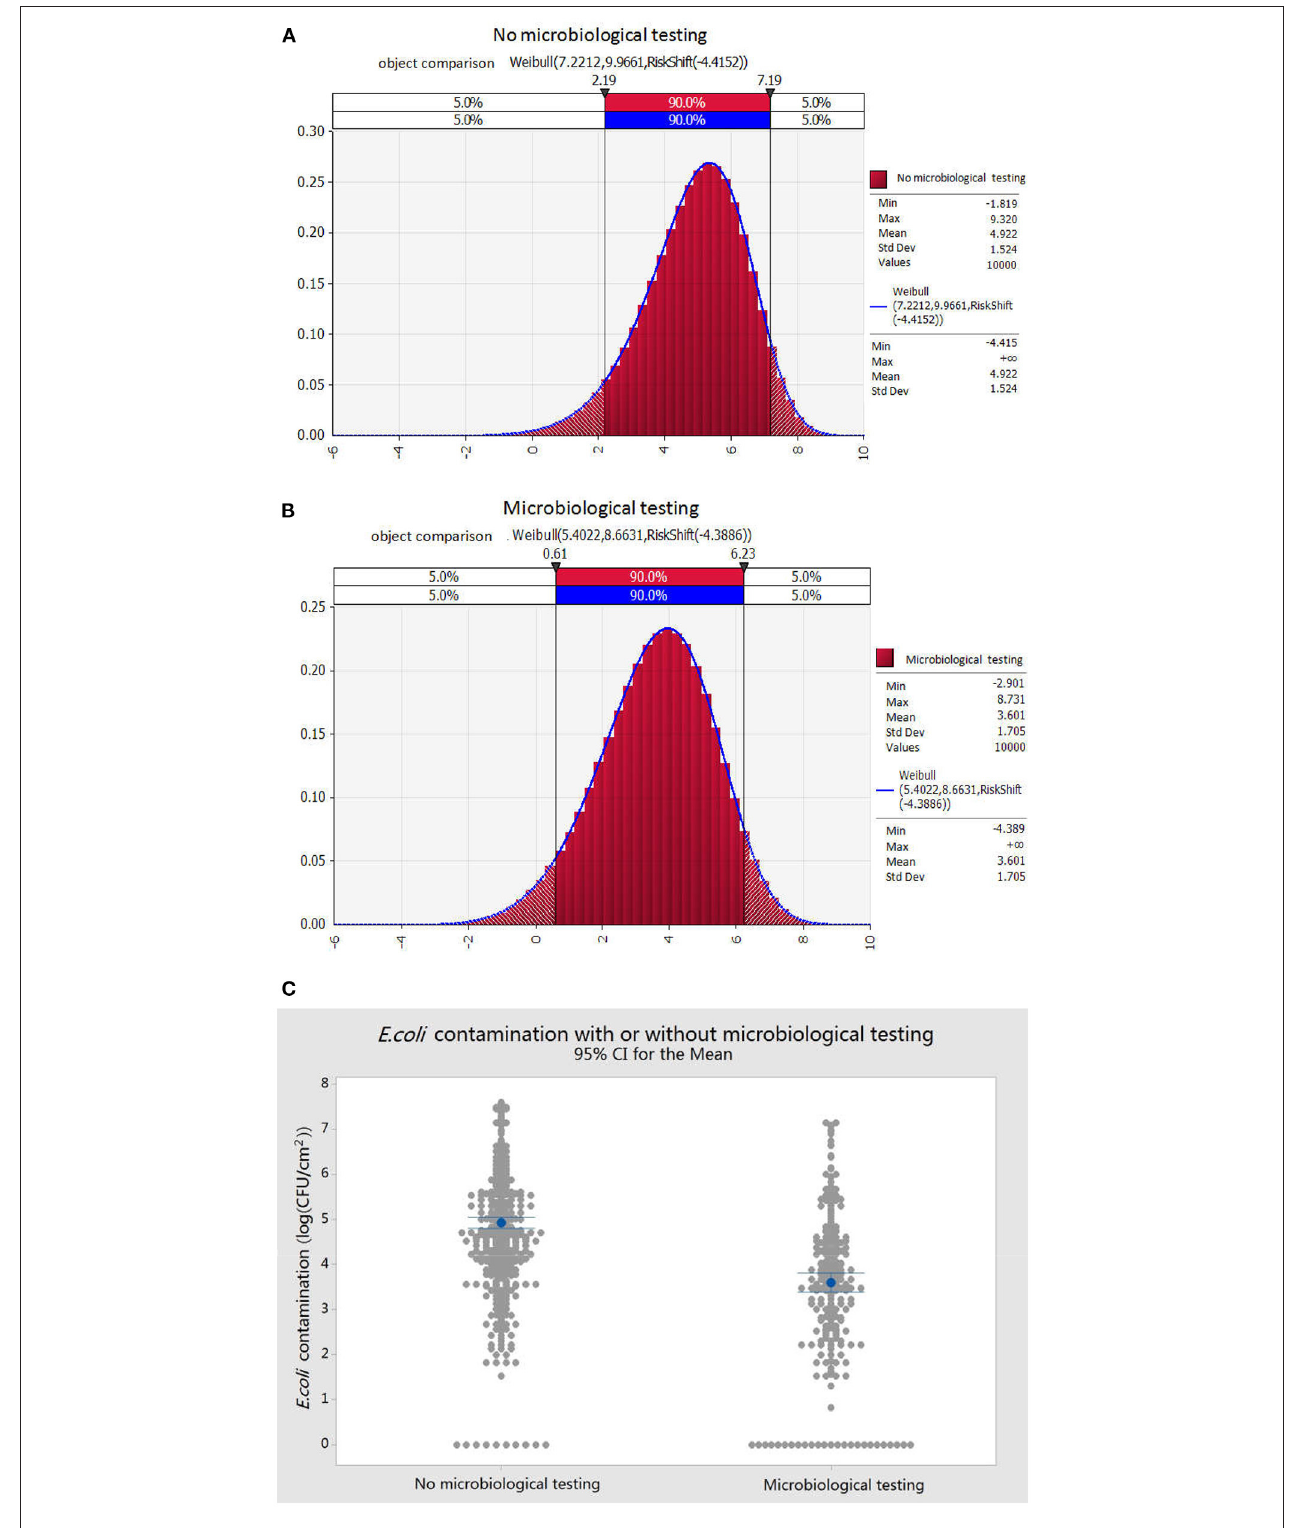
FIGURE 3 | Effects of microbiological testing on E. coli contamination of pork after slaughter. (A) Contamination distribution of E. coli in pork during slaughter with microbiological detection. (B) Contamination distribution of E. coli in pork during slaughter without microbiological detection. (C) Comparison of E. coli contamination in pork during slaughter with or without microbiological